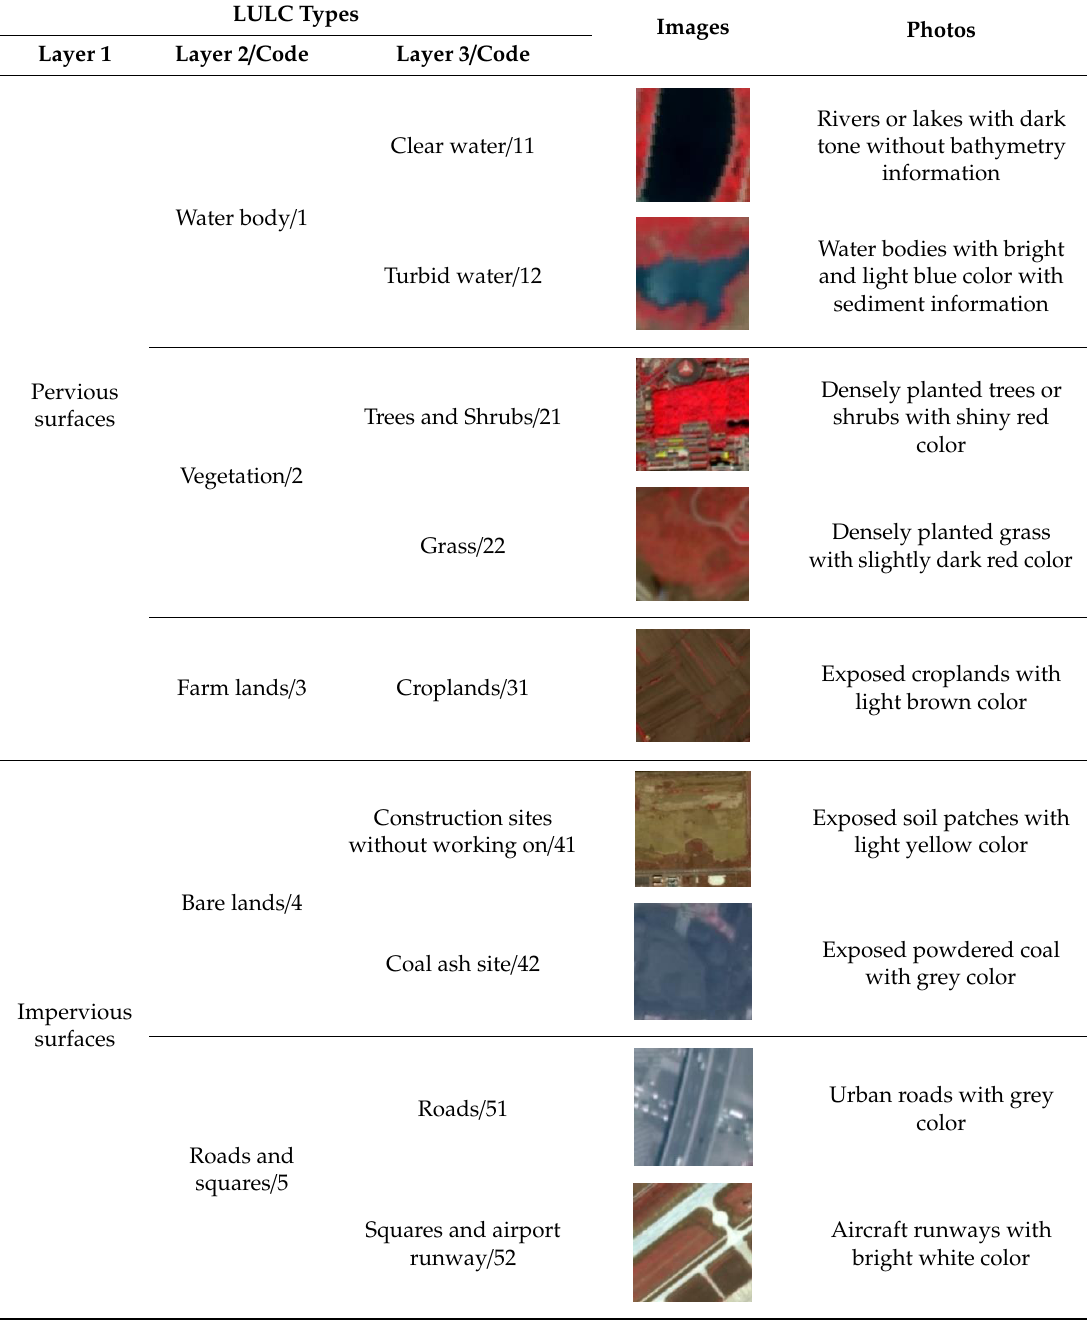
Figure 3. Flowchart of image pre-processing.